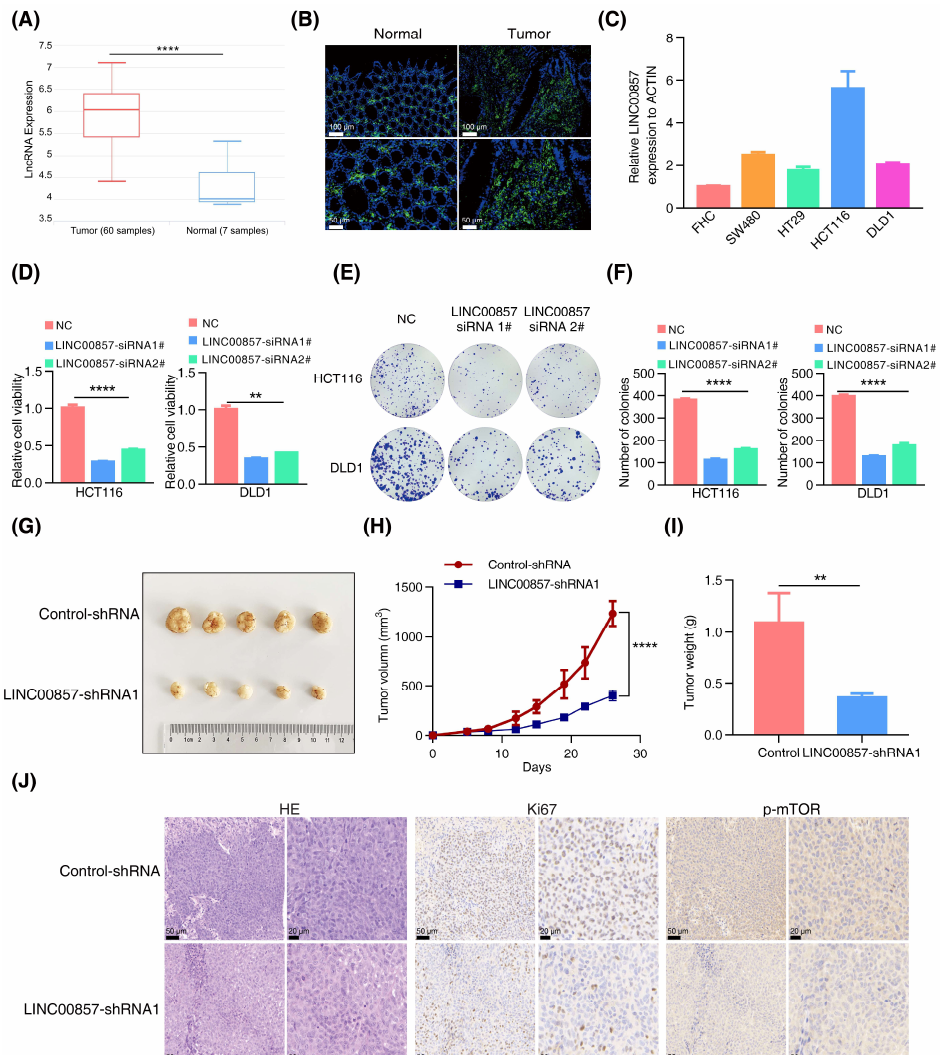
Figure 4. LINC00857 is upregulated and beneficial for CRC carcinogenesis. ( A ) Analysis of LINC00857 expression levels by data from the lnCAR database (CR_S177). ( B ) The expression of LINC00857 in CRC tissues and paired normal samples was determined by FISH (fluorescence in situ hybridization) (scale bar, 50 µ m and 100 µ m). ( C ) The relative expression of LINC00857 in